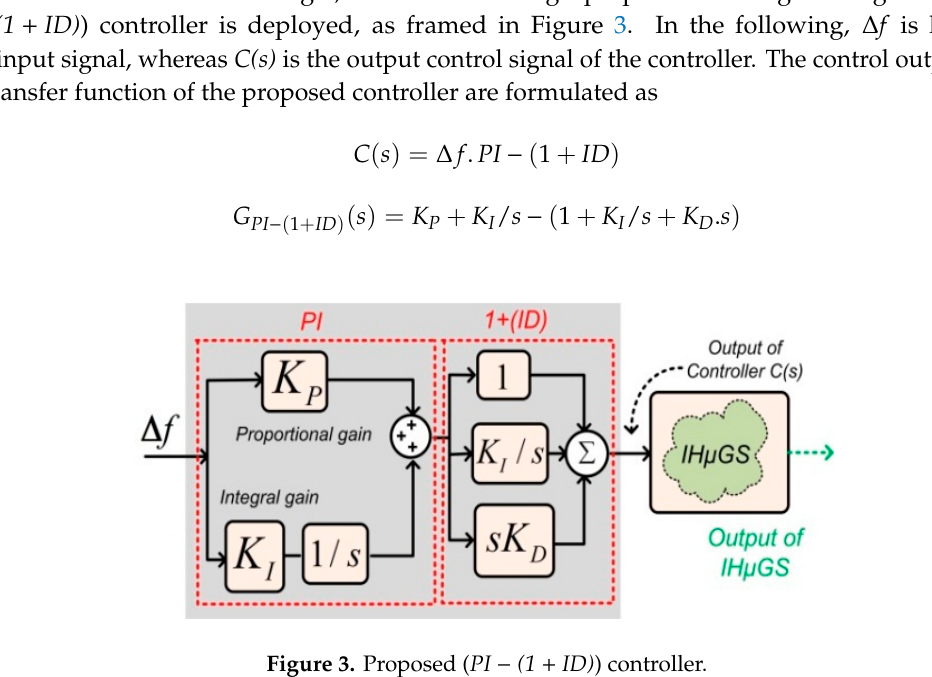
Figure 2. Flow diagram of butterfly optimization technique (BOA).